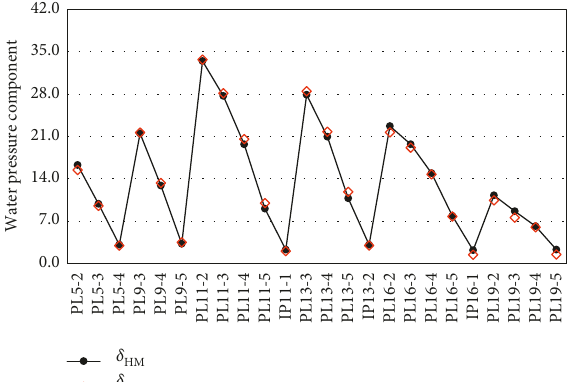
Figure 15: Water pressure component δ